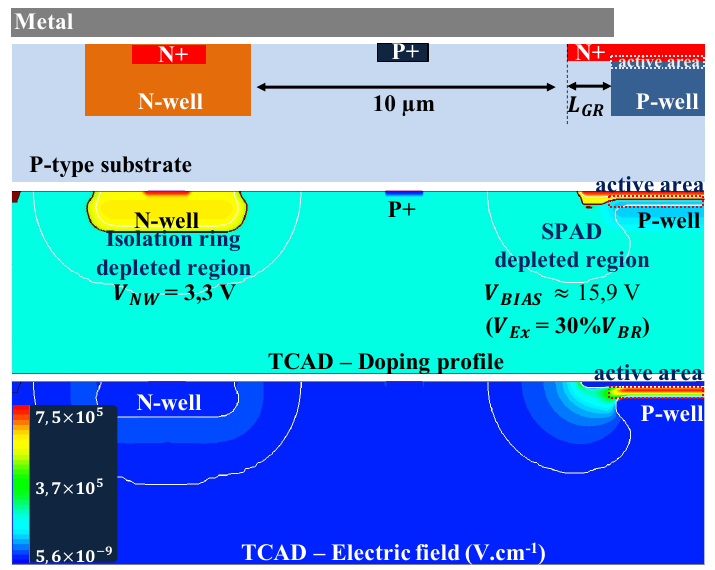
Figure 5. 2D electrical field distribution of the SPAD under investigation for an excess voltage V Ex = 30% V Br ). The plots“TCAD–Doping profile” and “TCAD–Electric field” are directly taken from the TCAD software and are drawn to